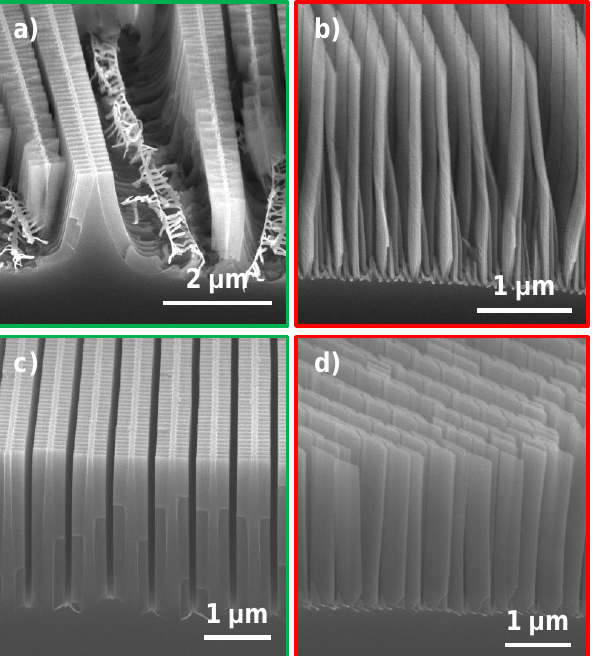
Figure 6. The effect of IPA on etching verticality. ( a ) fishbone and ( b ) brick wall catalyst designs etched at condition C1 (no IPA, same Si chip), and ( c ) fishbone and ( d ) brick wall catalysts etched at condition C4 (with IPA, same Si chip). The MACE time was 9 min for both samples. The cross-sections were prepared by cleaving.